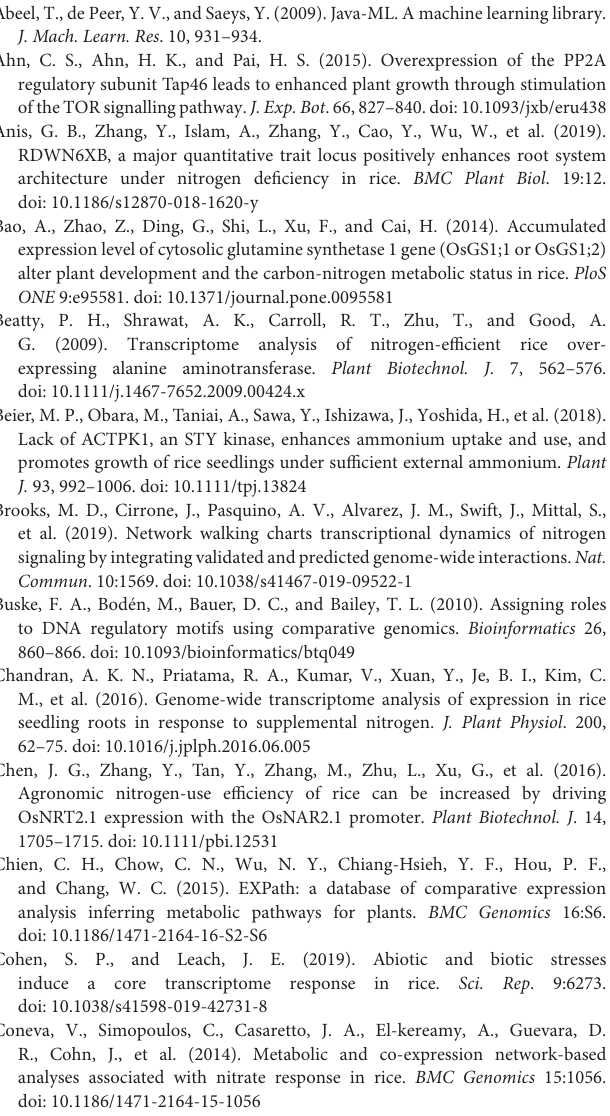
Supplementary Table S18 | Functionally characterized 137 NUE-related genes by OGRO database. Supplementary Table S19 | Shortlisted 114 candidate genes for NUE and their functional characterization by OGRO database. Supplementary Table S20 | Protein involved in protein–protein interaction (PPI) network among 114 NUE-related genes. Supplementary Table S21 | GO analysis of 62 interacting genes of the main network by Expath 2.0. Supplementary Table S22 | Functional characterization of 62 interacting genes of the main network through OGRO database. Supplementary Table S23 | Common NUE-genes among Feature Selection analysis and hierarchically shortlisted